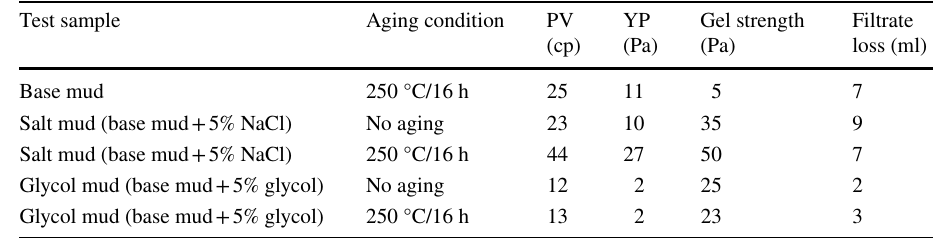
Table 4 Effect of salt and glycol on mud properties